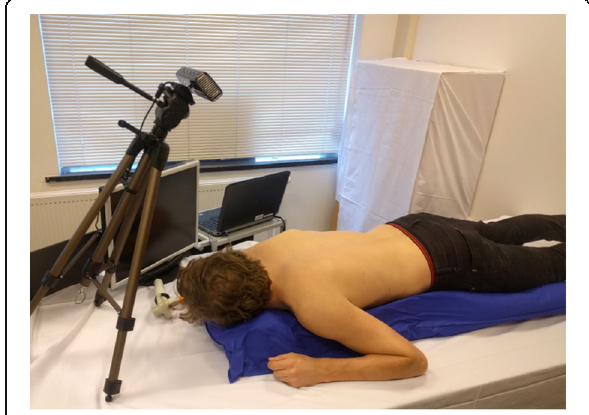
Fig. 2 Experimental setup. Setup of how the Kinect was used in this study. Volunteers could see the visual biofeedback on the additional